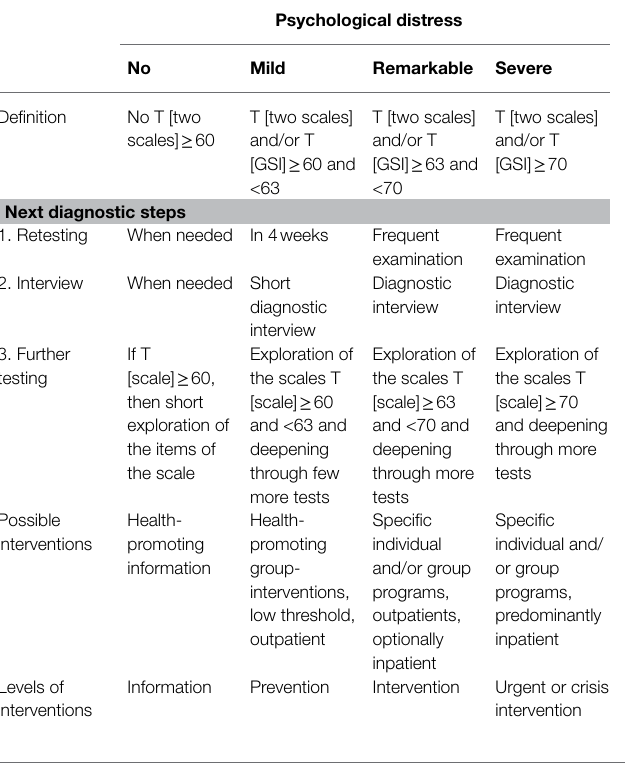
TABLE 1 | New case definition for Brief Symptom Inventory (BSI) to evaluate psychological distress: the four groups according to the new case definition as well as recommendations for further diagnostics and interventions are